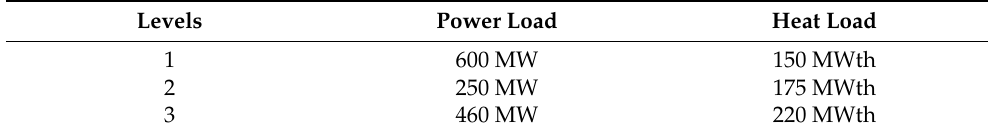
Table 1. Considered loading levels under